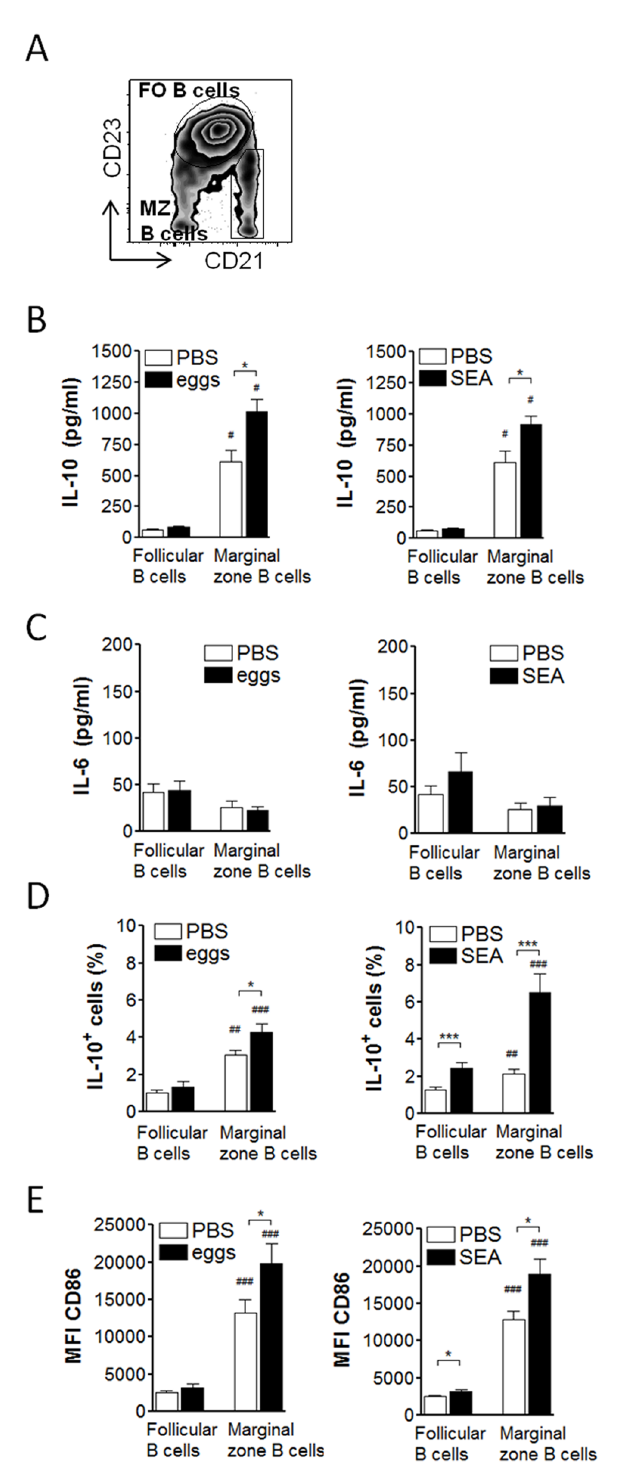
Fig 2. Schistosome antigens mainly activatethe marginal zone B cell subset of the spleen. C57BL/6 were treated as in Fig 1, splenic follicular (FO) B cells (CD19 + CD23 + CD21 low ) and marginalzone (MZ) B cells (CD19 + CD23 - CD21 hi ) FACS sorted, and restimulated for 2 days with SEA (20 μ g/ml). (A) Gating scheme for both B cell subsets within the CD19 + gated B cell population. (B, C) Cytokine concentration in culture supernatants as determinedby ELISA. (D) IntracellularIL-10 expressionof B cell subsets after additionof